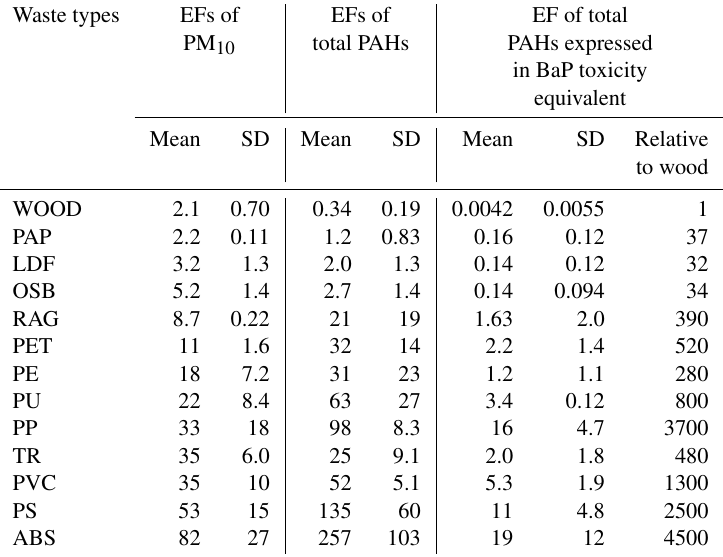
Table 1. The absolute emission factors of PM 10 (mgg − 1 ) , total PAHs (mg PAHskg − 1 of fuel) and total PAHs expressed in BaP toxicity equivalent (mgkg − 1 of fuel) from wood burning and residential waste